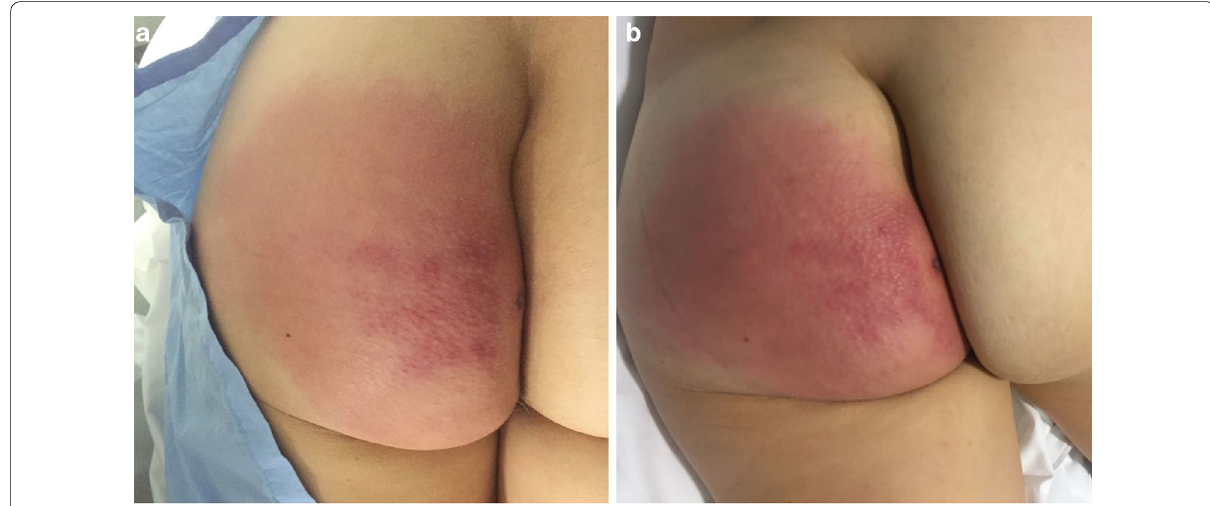
Fig. 1 Macroscopic aspect of the left gluteus with signs of cutaneous infection: a at admission and b 3 h after admission, showing rapid progression of the redness around a central area of